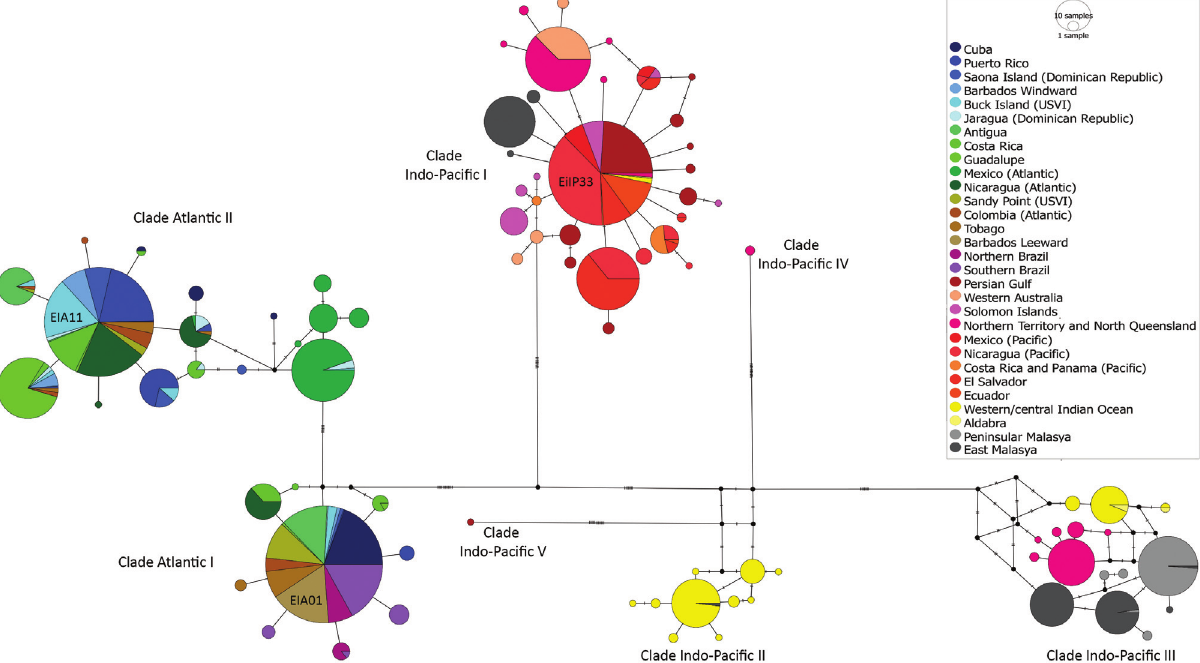
Figure 3 - Haplotype (Median Joining) network based on control region of mtDNA (739 bp) found in hawksbill turtle rookeries. Colors correspond to the 30 geographical groups. Small black dots represent median